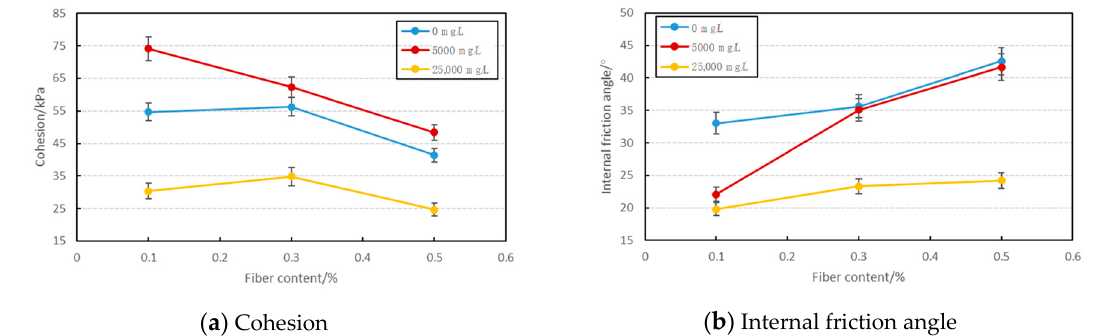
Figure 18. Effect of fiber content on the evolution of the shear strength parameters (cohesion and internal friction angle) of the FR-CPB / rock interface for various initial sulfate concentrations (treated for 7 days).